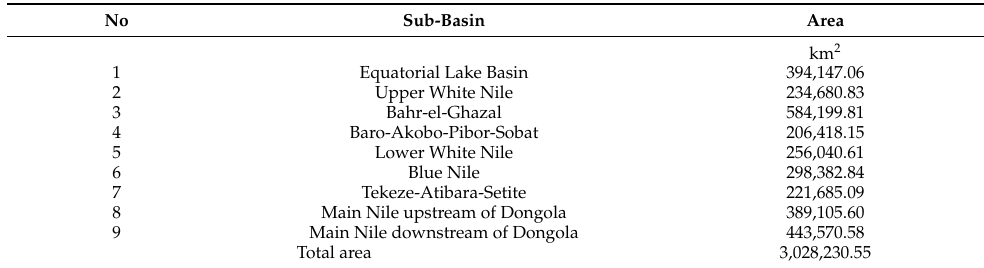
Table 1. NR sub-basins and their drainage area.